Question: Give a one-sentence summary of this figure.
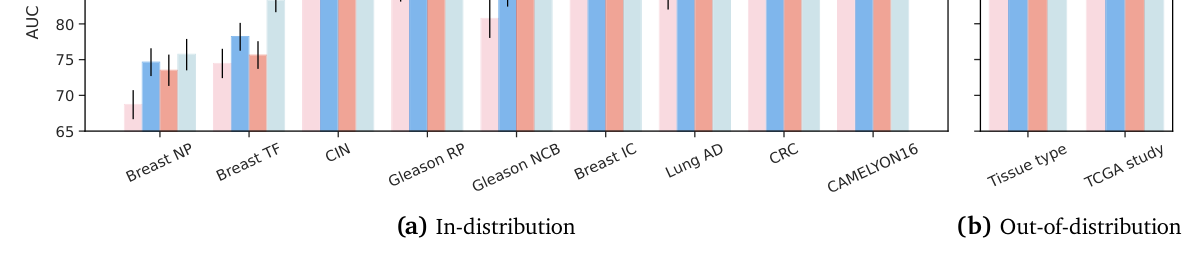
Answer: | Med-Gemini-2D histopathology image classification performance. Linear-probing on histopathol- ogy patch-classification tasks (macro-averaged AUC percentages with 95% confidence intervals) on our in- distribution and held-out out-of-distribution tasks. Overall, while Med-Gemini-2D outperforms Gemini Ultra on 7 out of 9 in-distribution tasks and on both out-of-distribution tasks, it does not improve over a histopathology- specific foundation model (PathSSL) on any of our tasks.